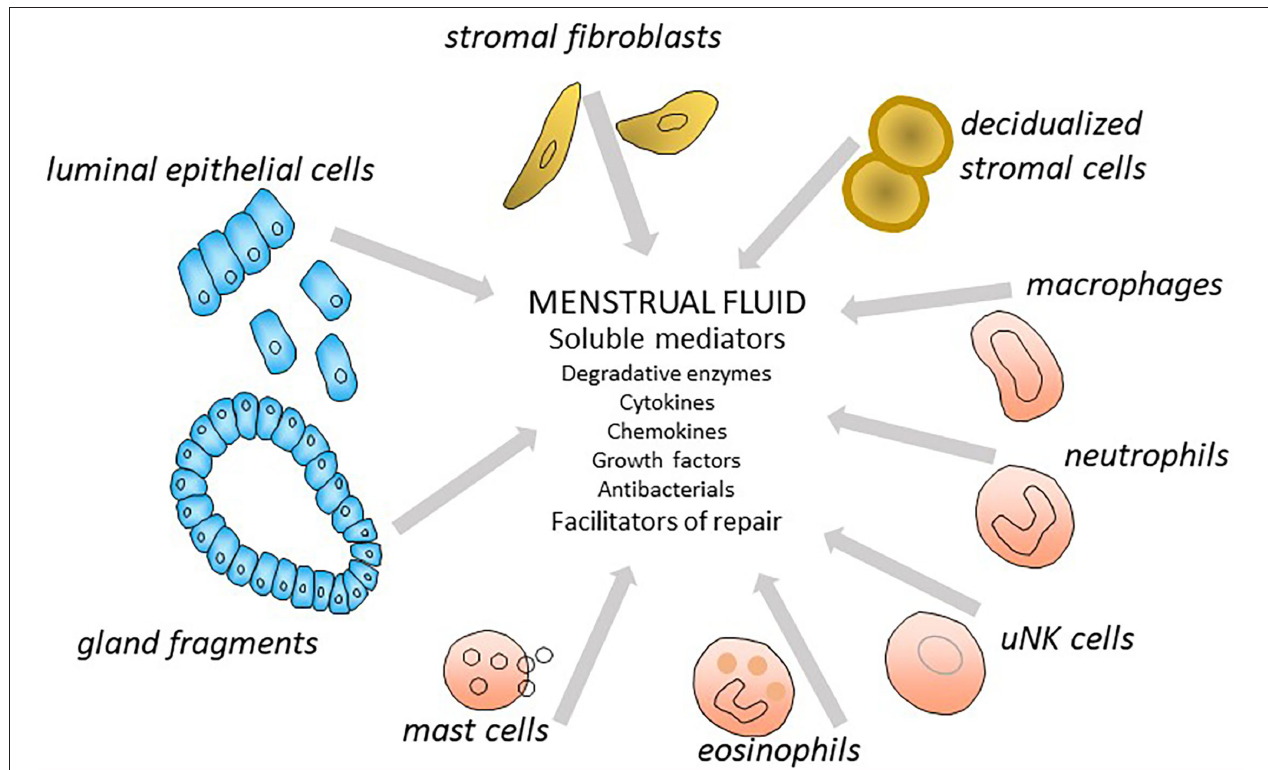
FIGURE 1 | The likely cellular origins of soluble components of menstrual